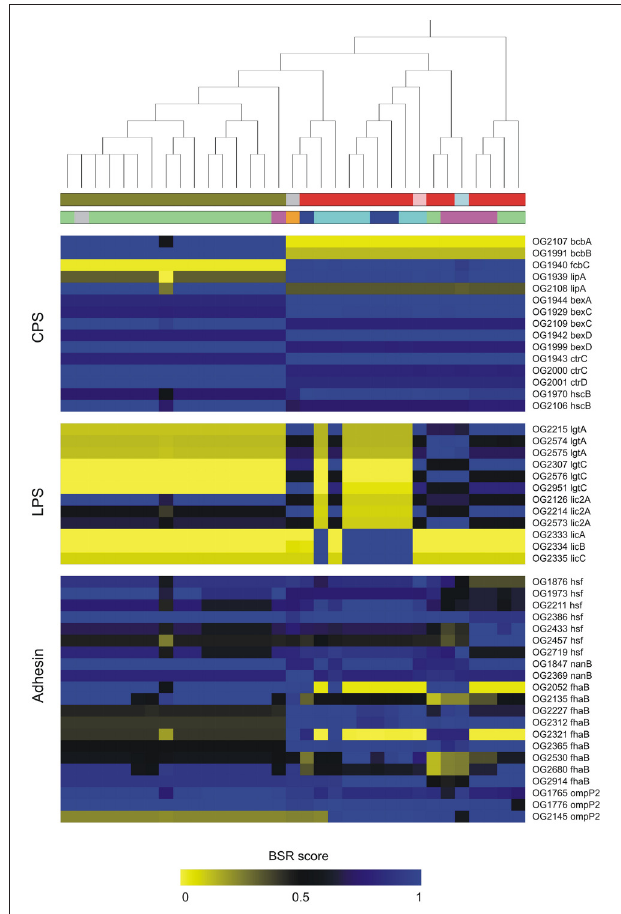
FIGURE 4 | Distribution and conservation of selected genes coding for putative virulence factors in P. multocida . Putative virulence-associated genes were identified by blastp searching OGs against VFDB. The conservation of virulence markers in the pan-genome across all genomes is color-coded based on BLAST Score Ratio (BSR) values. The top dendrogram is the core SNP phylogeny. Color strips underneath the dendrogram represent serotypes and host origin with the same scheme shown in Figure 2 . Gene annotations are detailed in Table